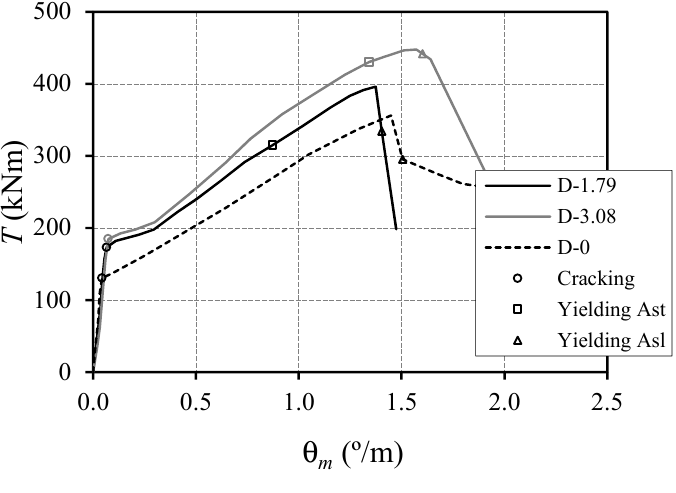
− T curves. Figure 8. T – θ m m